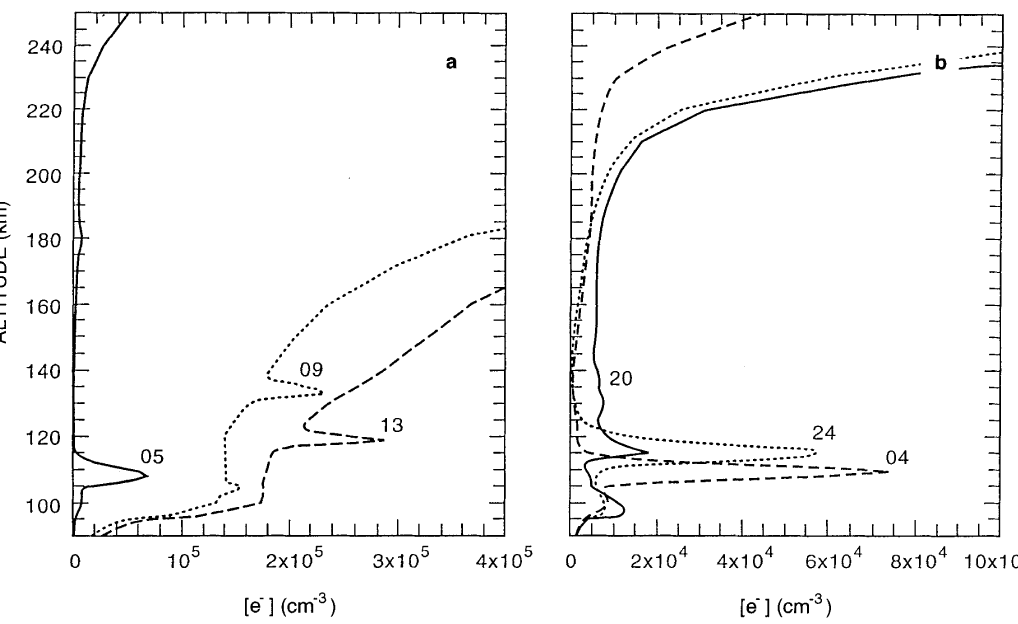
Fig. 7a, b. Vertical profiles of total plasma density, showing evolution of a the morning descending layer and b the evening descending layer. Curves and labeled with local